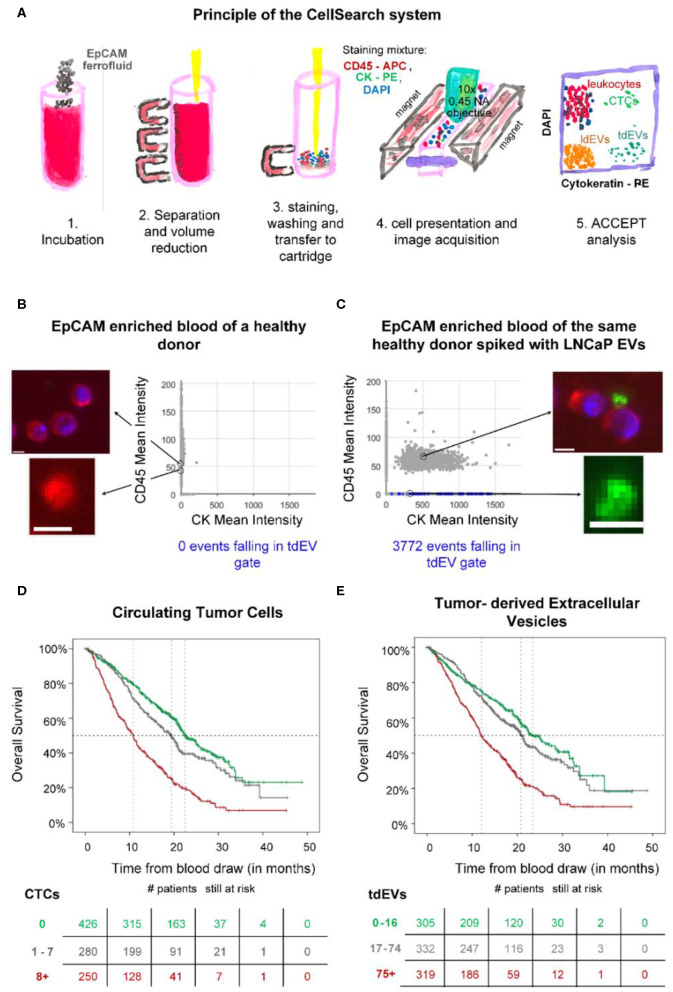
Epithelial cell adhesion molecule (EpCAM) immunomagnetic enrichment and fluorescence microscopic (FM) detection of extracellular vesicle (EV) samples. (A) Principle of the CellSearch system. ACCEPT analysis of two CellSearch cartridges corresponding to EpCAM-enriched blood sample of a healthy donor (B) without and (C) with LNCaP EVs spiked. CD45 is depicted in red, CK in green, and 4′,6-diamidino-2-phenylindole (DAPI) in blue. The objects falling in the applied tdEV gate are depicted as blue dots in the scatter plots of CD45 mean intensity vs. CK mean intensity. The other particles are shown as gray dots. Thumbnail examples of four objects are shown. The CD45+ and CK+ particles are attached to the leukocytes, as illustrated. Scale bars indicate 6.4 μm. (D,E) show Kaplan Meier plots of overall survival of 956 metastatic colorectal, prostate, breast, and nonsmall cell lung cancer patients. Patients were grouped based on their (D) circulating tumor cells (CTC) or (E) tumor-derived EV (tdEV) counts demonstrating the equivalent prognostic power of CTCs and tdEVs (9).